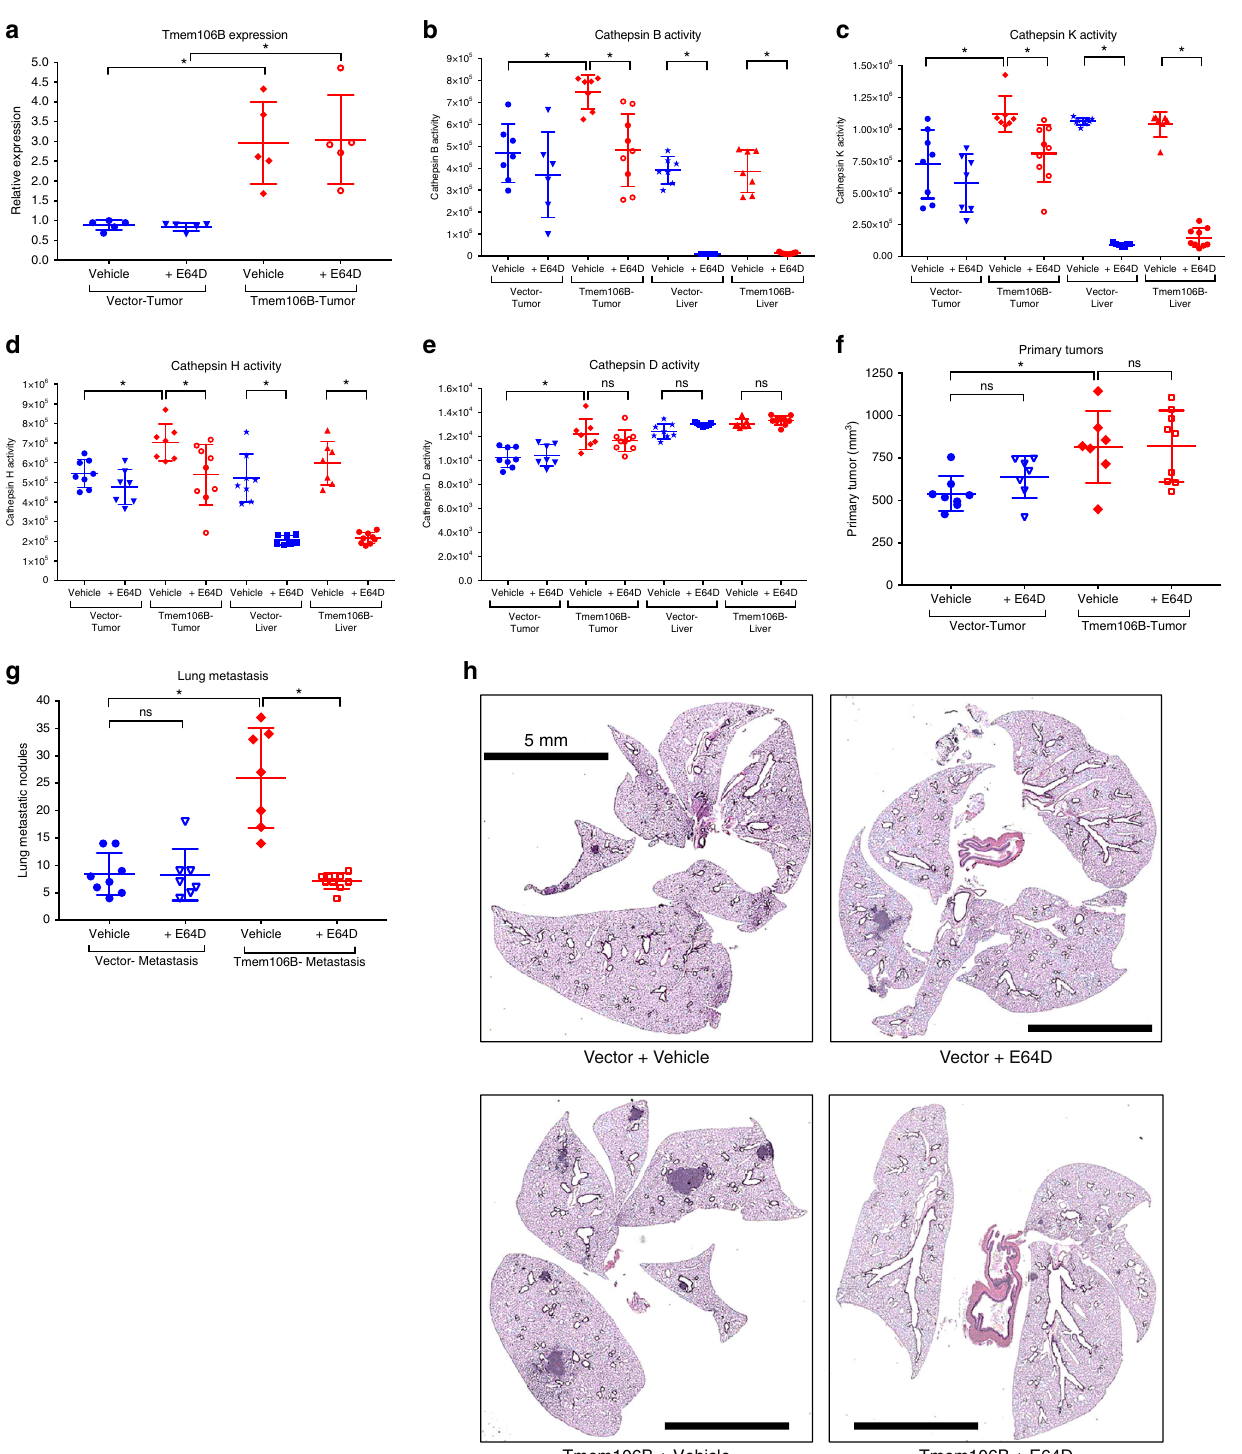
Fig. 8 Inhibition of cathepsins in vivo results in abrogation of TMEM106B -mediated increase in lung metastasis. The Vector alone or TMEM106B -induced cells were injected subcutaneously into syngeneic hosts and treated daily with either Vehicle control (Placebo) or with 25 mg/kg of E64D. a qPCR analysis for TMEM106B expression in primary tumor tissue from mice of different cohorts as indicated. b – e Activity of indicated cathepsins were assessed using speci fi c activity assays in tissue lysates from either primary tumors or liver in the different cohorts as indicated. f Observed primary tumor growth and g formation of metastatic nodules in lungs. h Representative H&E-stained lungs sections are shown from different cohorts as indicated. Lungs from mice injected with TMEM106B -induced cells show signi fi cantly more incidence of lung metastasis which are abrogated upon treatment with E64D. All asterisks indicate statistical signi fi cance by t test ( n ≥ 3, * p ≤